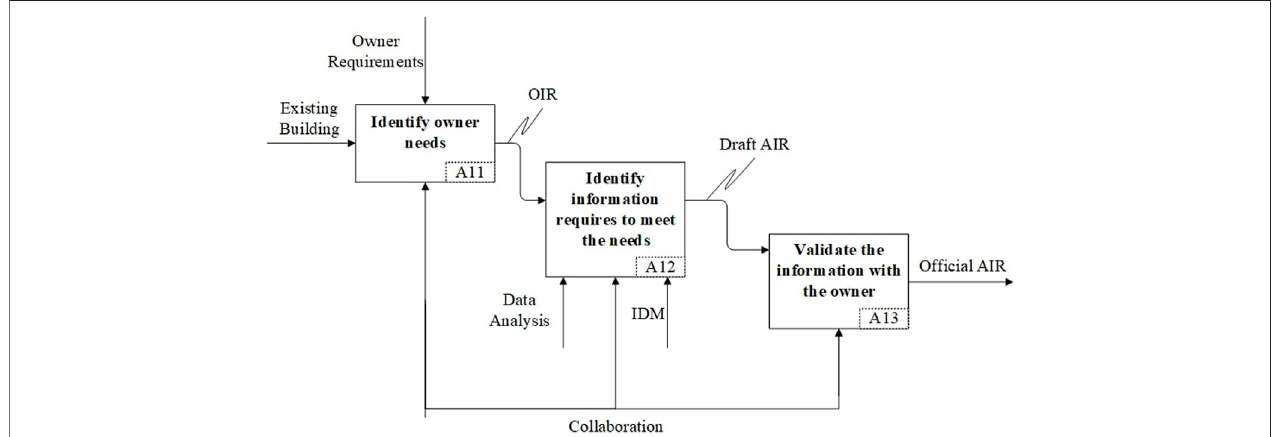
FIGURE 4 | Process model of the development of asset information requirements